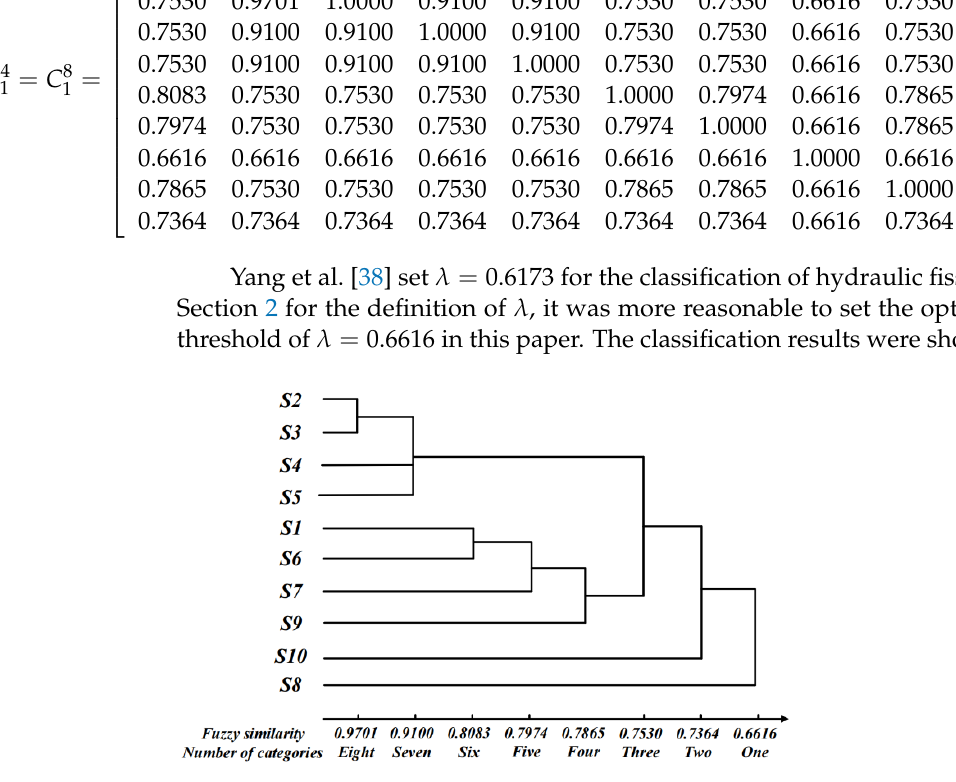
Figure 4. Fuzzy clustering analysis results for 10 water gushing samples in the tunnel.